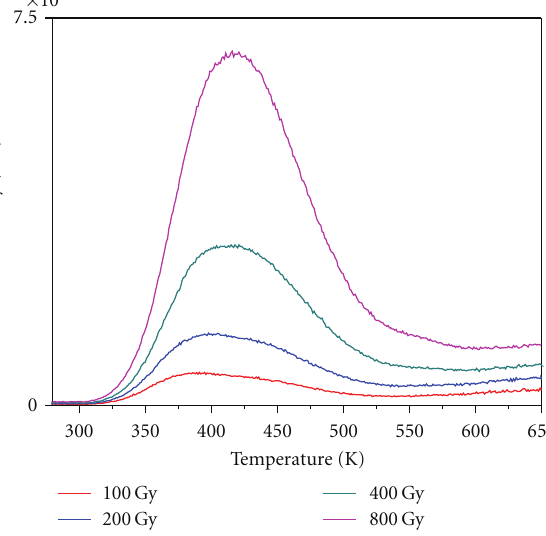
Figure 14: TL glow curves of MG 3 -Cu obtained by exposing to beta irradiation for di ff erent doses: 100–800